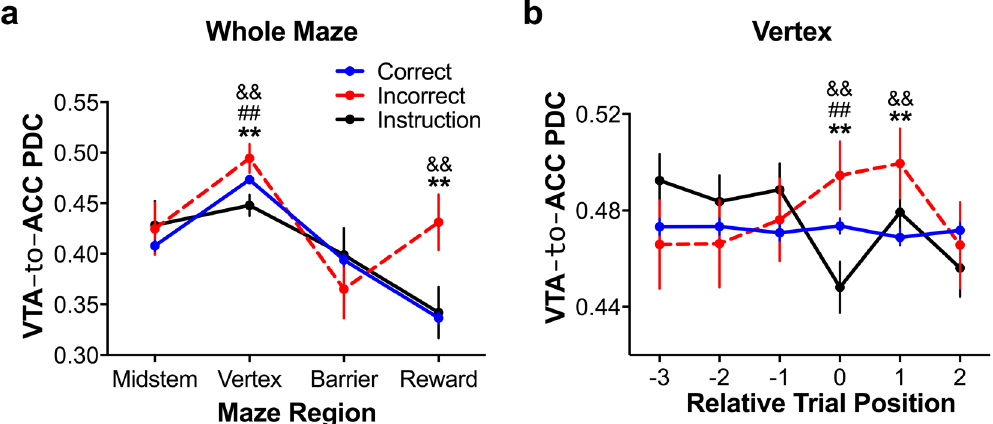
Figure 7. 4 Hz VTA → ACC PDC by trial type and maze region ( a ) and by trial type and trial position in the vertex region ( b ). ( a ) VTA → ACC PDC was significantly greater in the vertex and reward regions during incorrect trials, as compared to the other trial types. ( b ) Vertex VTA → ACC PDC models were greatest during incorrect choice trials and the post-error trials immediately following. Vertex VTA → ACC PDC models were lowest in magnitude during instruction trials. No differences in VTA → ACC PDC models were detected during the three trials leading up to each trial of interest, respectively, and no effect of trial type was detected two trials post-trial of interest. These data from phase A1 are presented as the mean ± SEM of the residual PDC model magnitudes. Because PDC is itself a normalised measure, data were not normalised. ** Indicates that correct choices were significantly different from incorrect choices at the p < 0.005 significance level via multiple comparisons tests; && indicates that incorrect and instruction trials were significantly different at the p < 0.005 significance level via multiple comparisons tests; ## Indicates that correct choices and instruction trials were significantly different at the p < 0.005 significance level via multiple comparisons tests. See also Fig. S5 for data processed without the regression